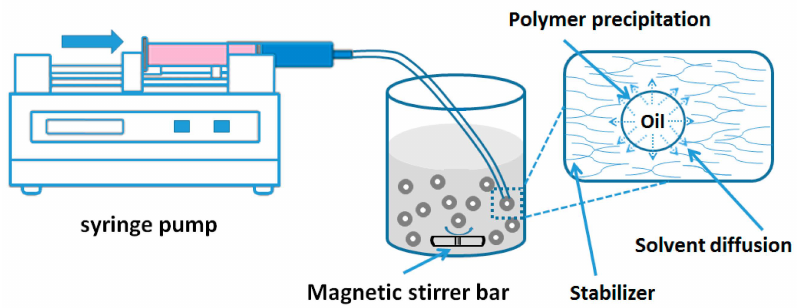
Figure 3. Preparation of NPs by nanoprecipitation method.